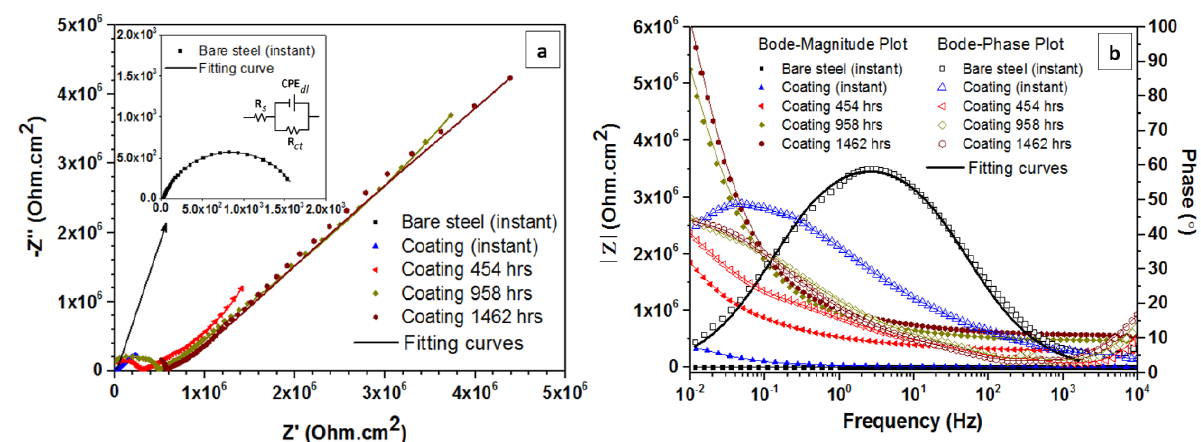
Figure 7. The experimental and fitted EIS curves of bare steel (at instant immersion time) and coated sample at four different measurement times, being 0 (instant), after 454, 958, and 1462 h of immersion; ( a ) Nyquist plots and ( b ) Bode plots; The inset graph in ( a ) illustrates the Nyquist plot of the bare steel sample together with the proposed equivalent circuit of the fitted